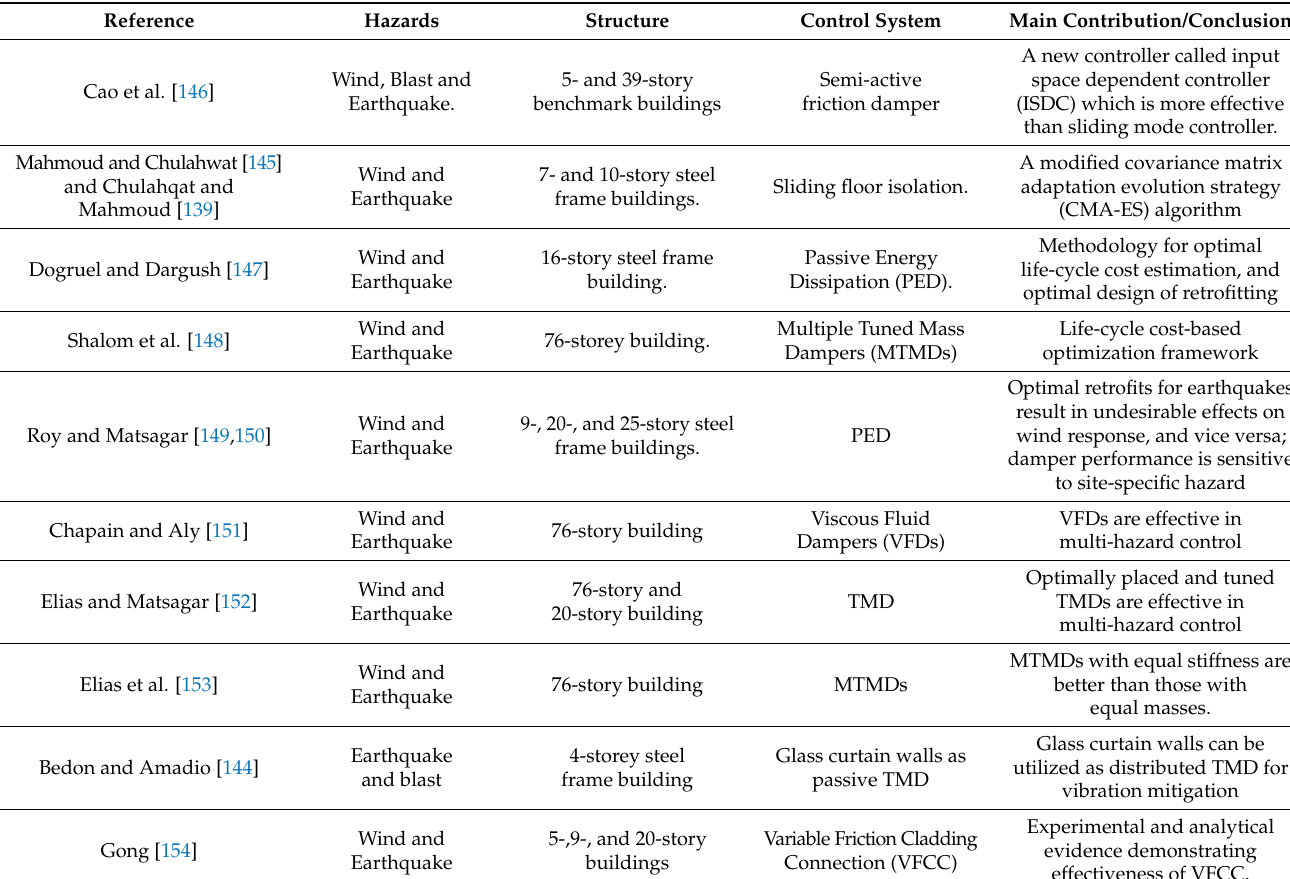
Table 2. A summary of published works on vibration control of the building subjected to